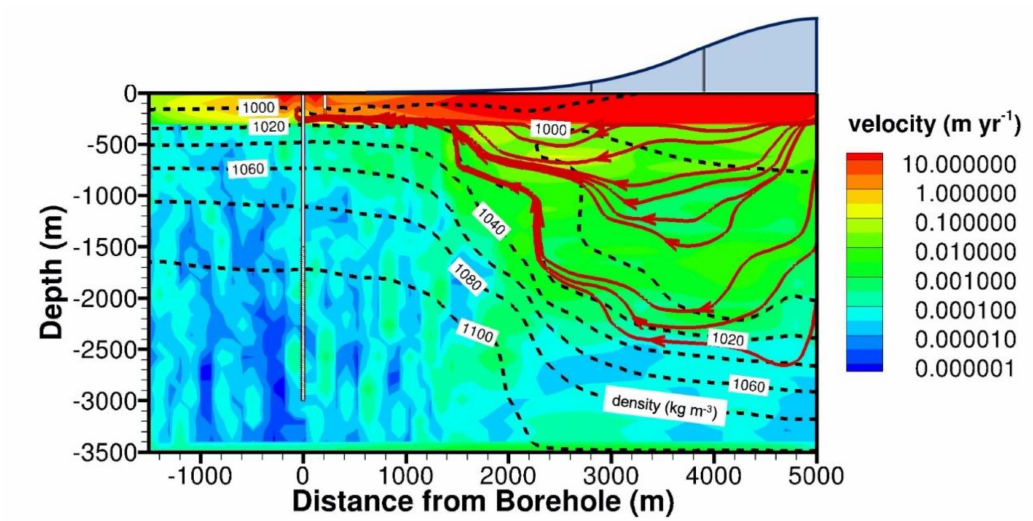
Figure 4. Initial conditions: Pore water velocity (color contours), fluid density (dashed contour lines), and streamtraces of regional flow field (dark red solid lines). The dark red streamtraces only visualize the direction of the flow field, without reflecting the magnitude of water flux. No streamtraces are shown in the region of essentially stagnant brine. Flow within the mountain ridge (blue-grey area) is not simulated explicitly. The borehole diameter is exaggerated by a factor of